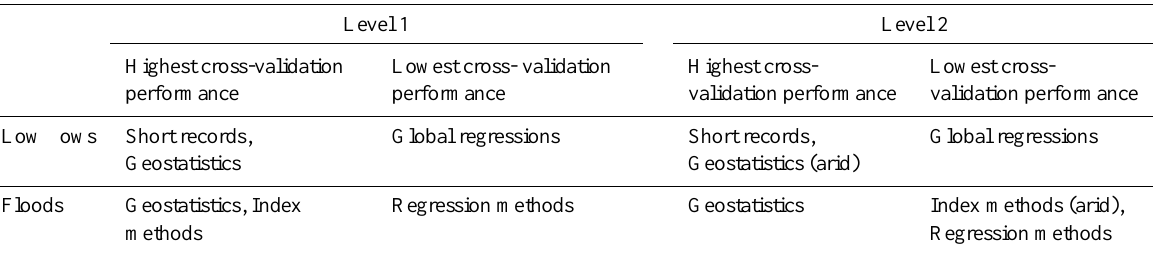
Table 4. Methods with the highest and lowest cross-validation performance of runoff predictions in ungauged basins. Arid relates to catch- ments with an aridity index > 1. Level 1 refers to an assessment of the average performance of studies, Level 2 to an assessment of the performance for individual catchments. For the number of studies and catchments see Table